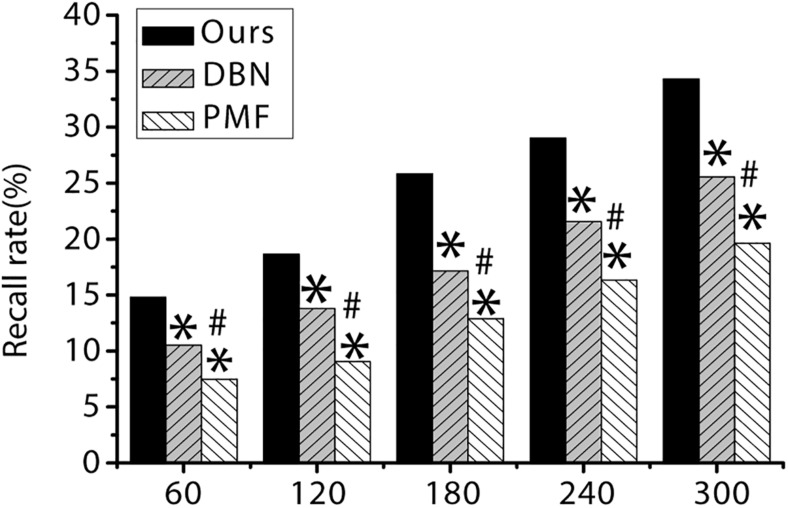
The recall rate of three algorithms under different item quantity. ∗ indicates that the difference is statistically significant compared with the algorithm proposed in the study (p < 0.05). # indicates that the difference is statistically significant compared with DBN algorithm (p < 0.05).